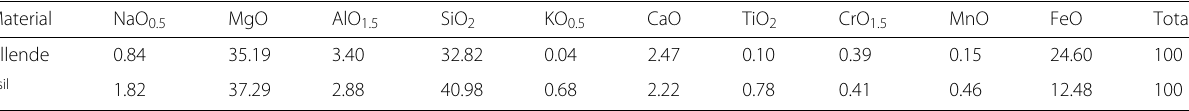
Table 1 The bulk chemical compositions of starting materials (mol%)